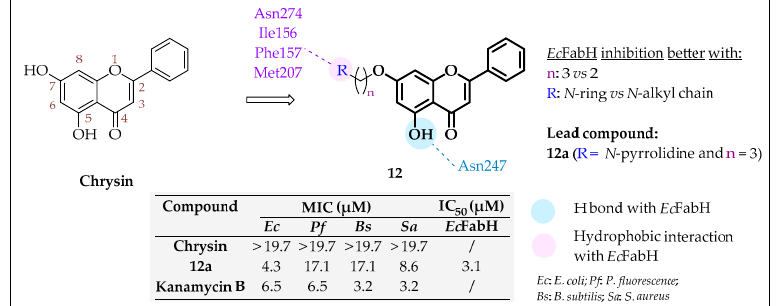
Figure 12. Structures, SAR and representation of main interactions with Ec FabH of chrysin and its analogues 12 and in vitro activities of lead compounds [43]. GSK3011724A (Figure 13) or N -(1-methyl-1 H -indazol-6-yl)butane-1-sulphonamide